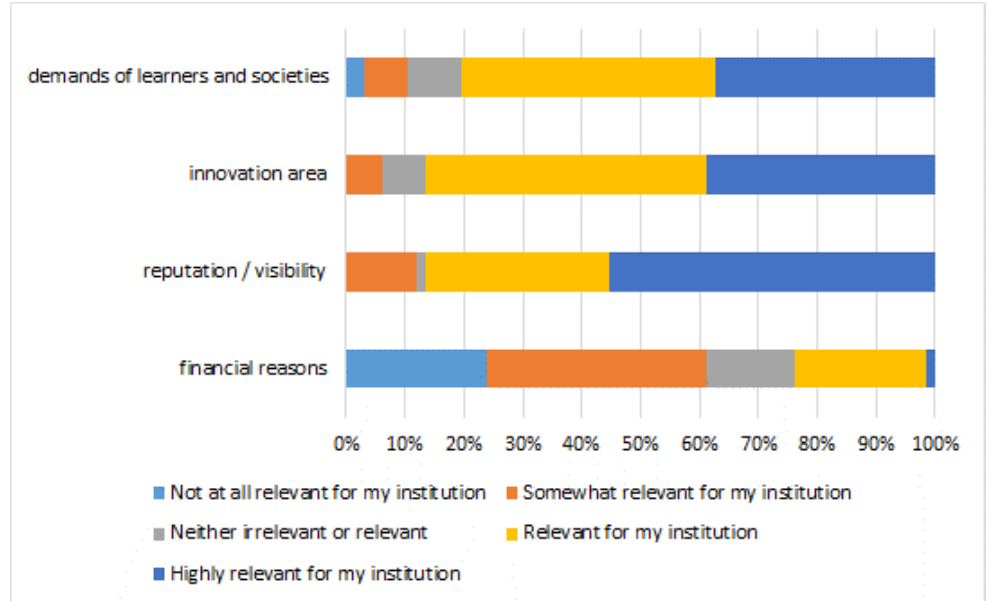
Figure 8 . Relevance of four different